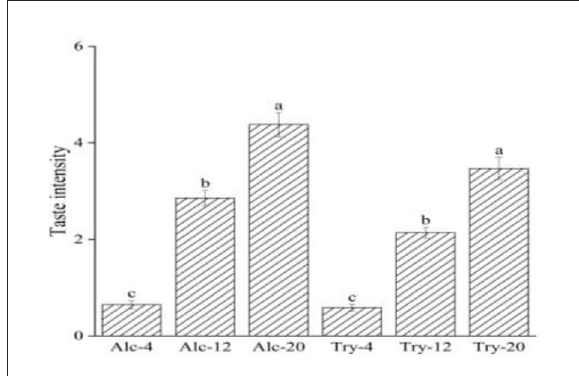
FIGURE1 Bitterness intensity scores of wheat gluten hydrolysates at 4, 12, 20% degree of hydrolysis. The values in a column followed by different letters were significantly different ( p < 0.05).